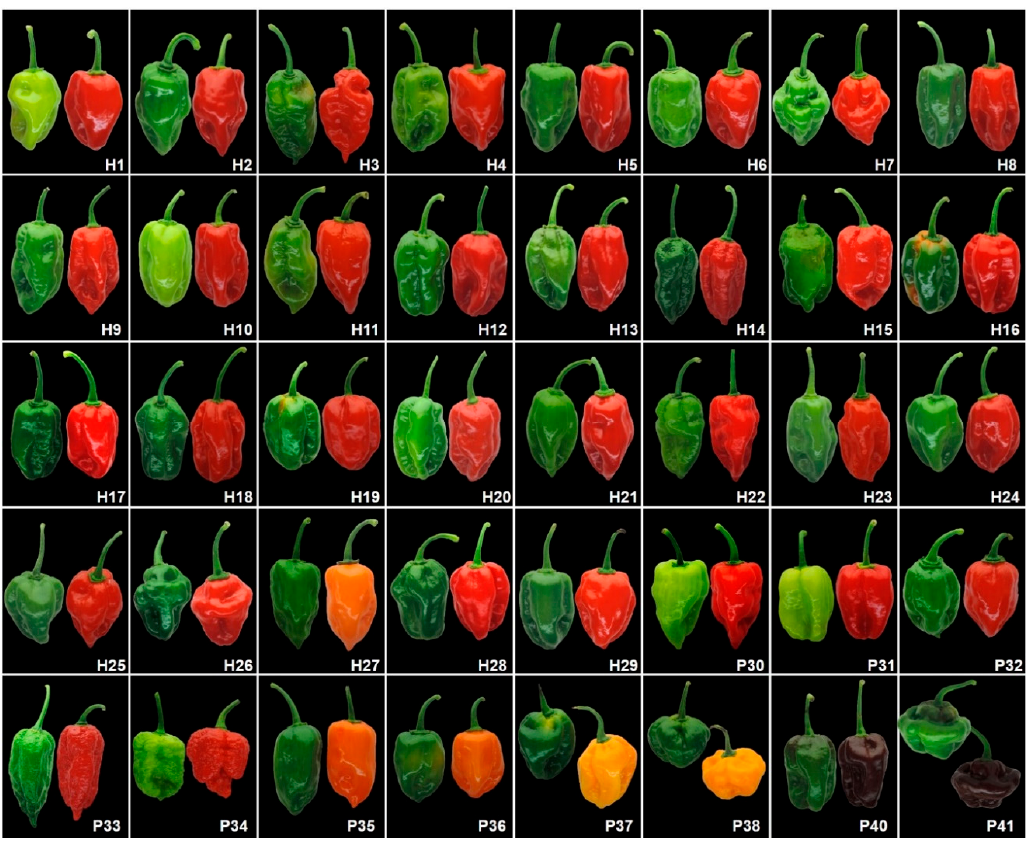
Figure 1. Evaluated F1 lines and the progenitors of habanero peppers. (Numbers H1–H29 correspond to F1 lines, and numbers P30–P41 correspond to progenitors).